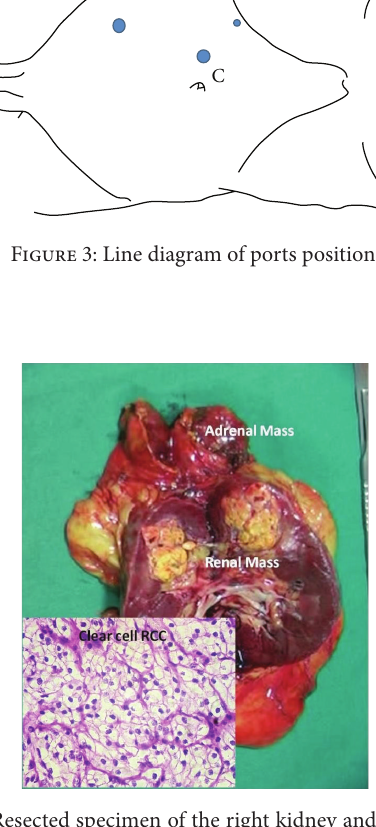
Figure 2: Ports position.